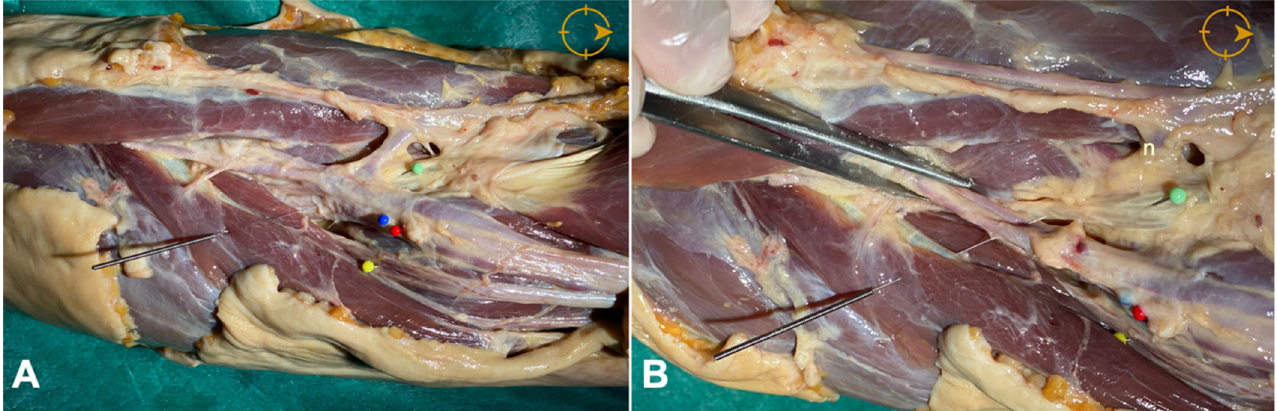
Figure 1. ( A ) Anatomical schematic of the relationship between the brachial artery and vein (blue and red pins), the median nerve (yellow pin), and the distal biceps tendon (green pin). ( B ) Detailed view (orientation arrow indicates: cranial).